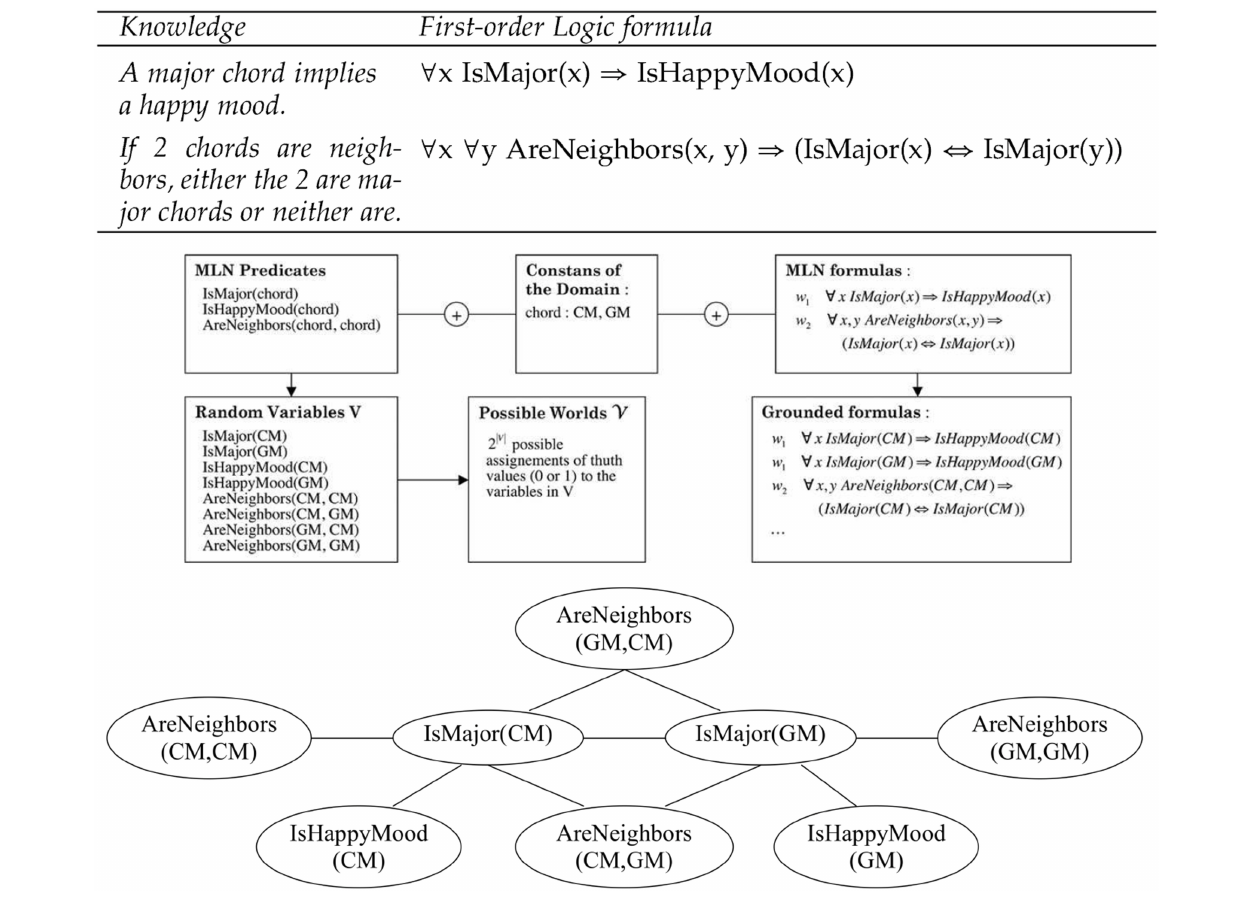
FIGURE 8 | Markov network (Bottom) obtained by applying two logical formulas (Top) (that describe knowledge about the relationship between chords and mood) to the two constants CM chord and GM chord. The logical formulas can be viewed as a template for constructing the Markov networks: given different set of constants, it will produce different networks; the size of the Markov network grows as the number of constants increases but the number of the formulas (or the templates) stays the same. The grounding process is illustrated in the (Middle) . For more details see Papadopoulos and Tzanetakis